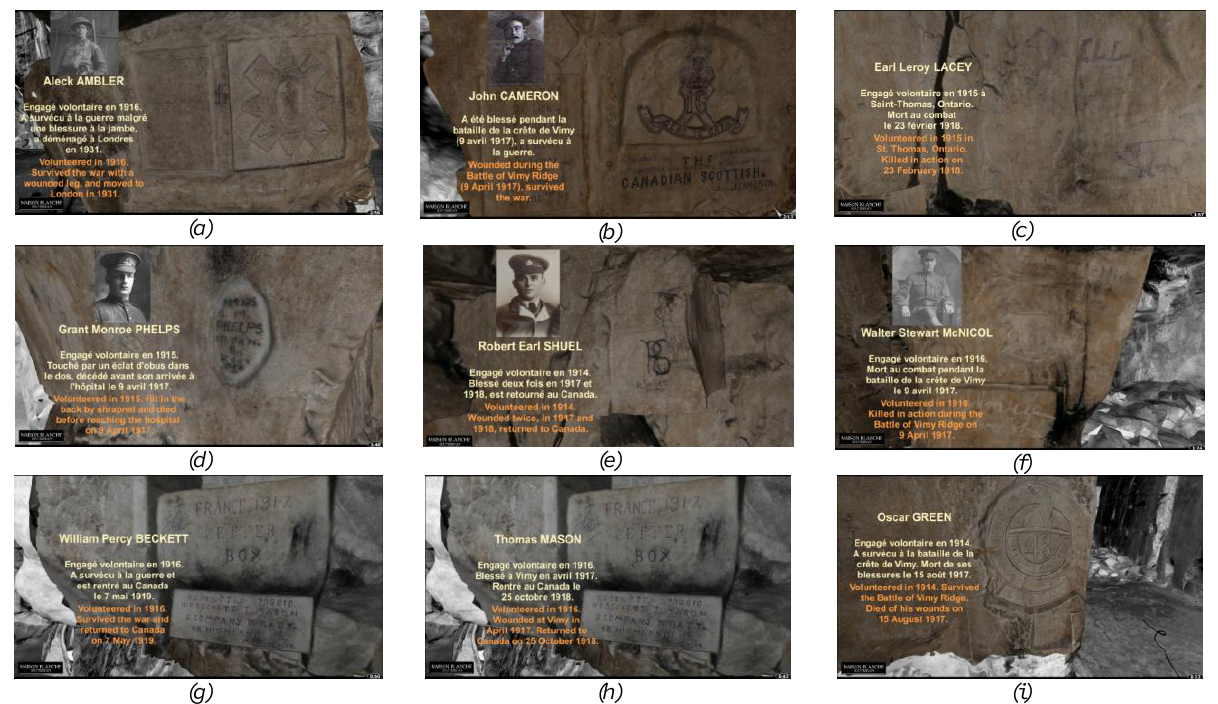
Figure 7. The nine soldiers identified in the virtual tour video: (a) A. Ambler, (b) J. Cameron, (c) E. L. Lacey, (d) G. M. Phelps, (e) R. E. Shuel, (f) W. S. McNicol, (g) W. P. Beckett, (h) T. Mason, and (i) O.